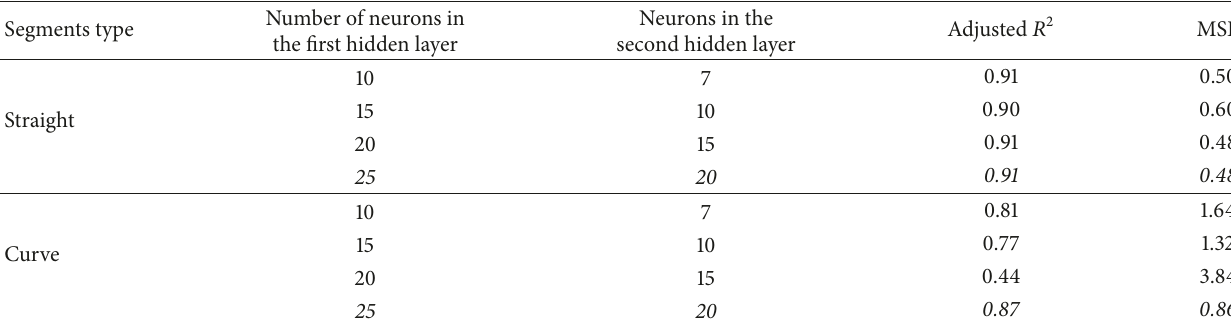
Table 5: Results of ANN models for unrepaired